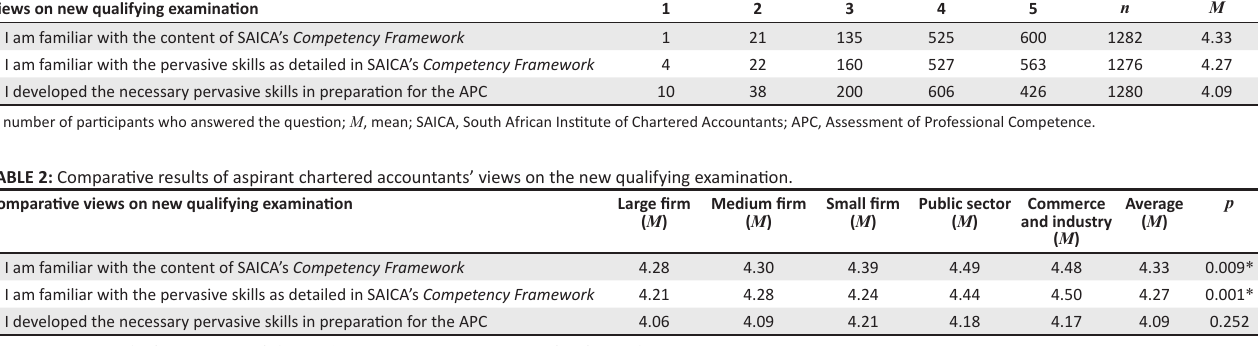
TABLE 1: Aspirant chartered accountants’ views on the new qualifying examination. Views on new qualifying examination